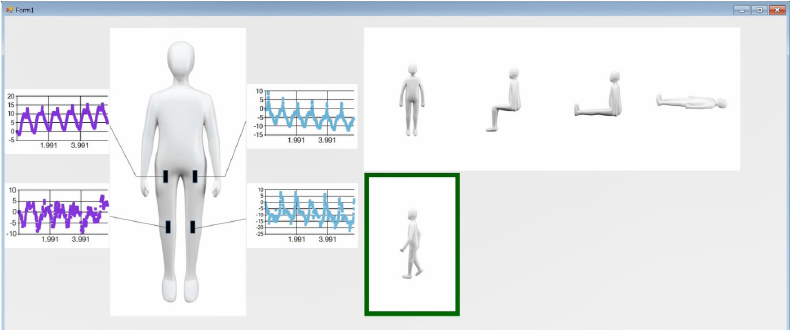
Figure 8. Captured computer screen showing patient walking detection and signal processed values from the four sensor